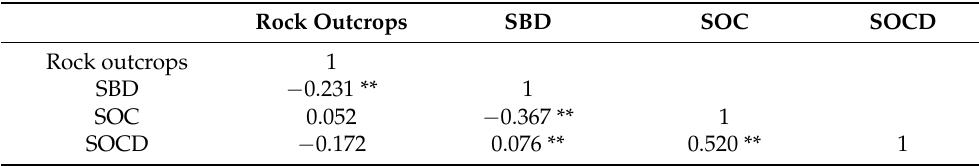
Table 3. Pearson correlation analysis of SOC, SOCD, SBD and rock outcrops. Rock Outcrops SBD SOC SOCD Rock outcrops 1 SBD − 0.231 ** 1 SOC 0.052 − 0.367 ** 0.076 ** 0.520